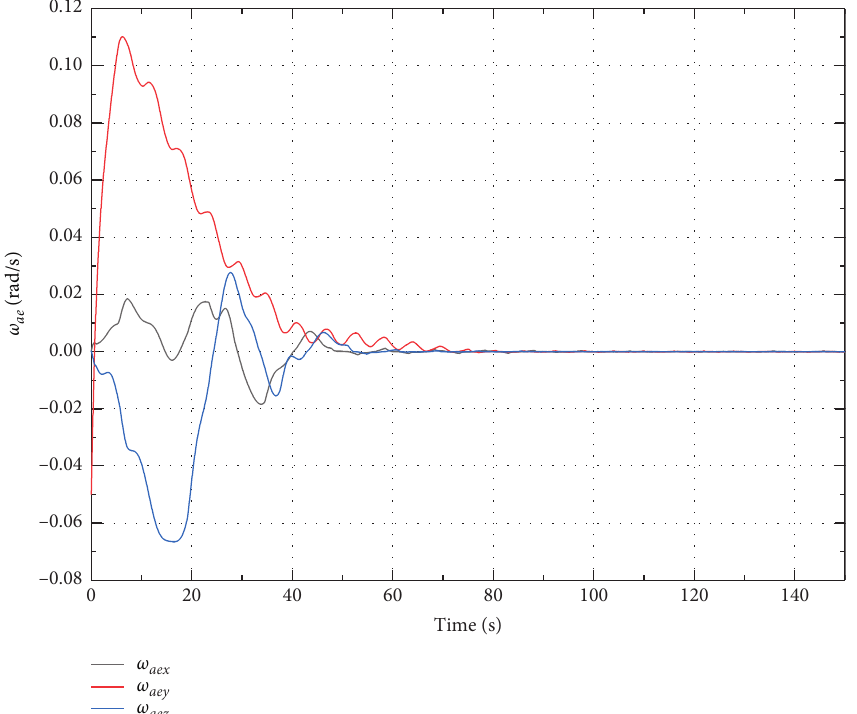
Figure 5: Trajectories of the error of attitude angular velocity of flexible solar